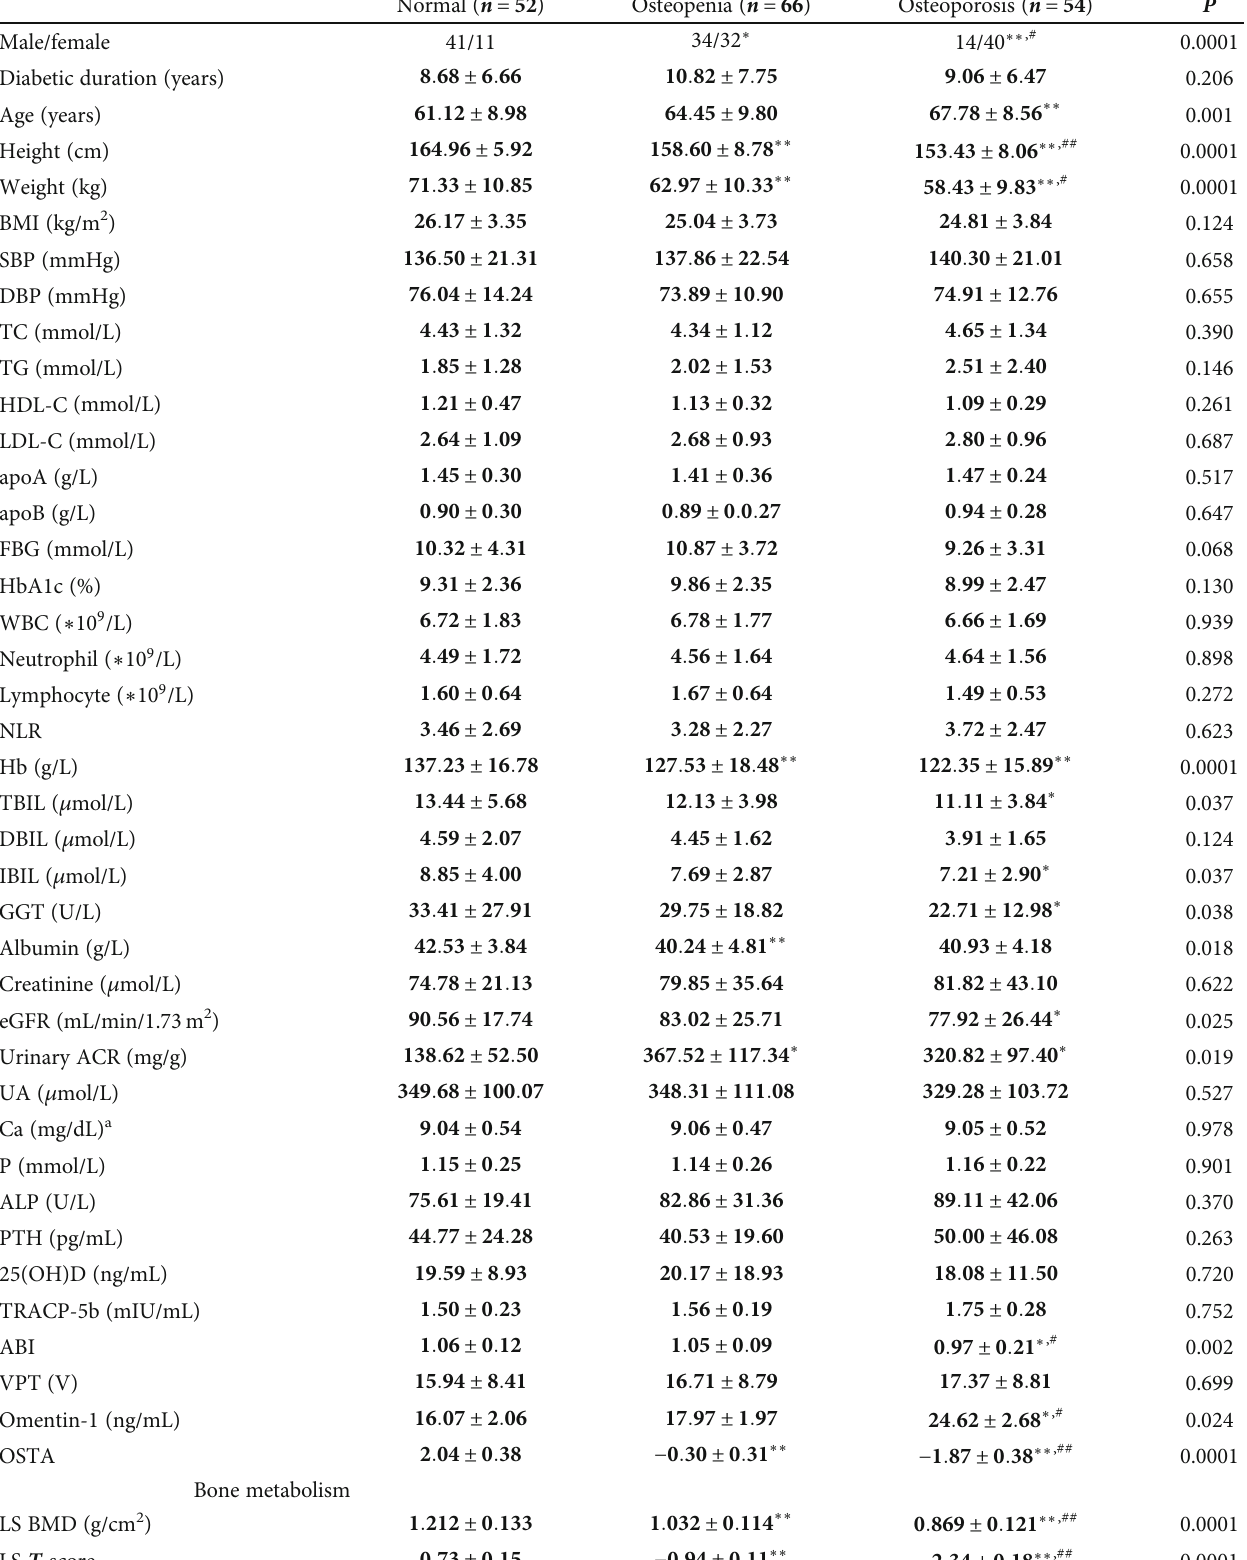
Table 1: Clinical and biochemical characteristics of the studied